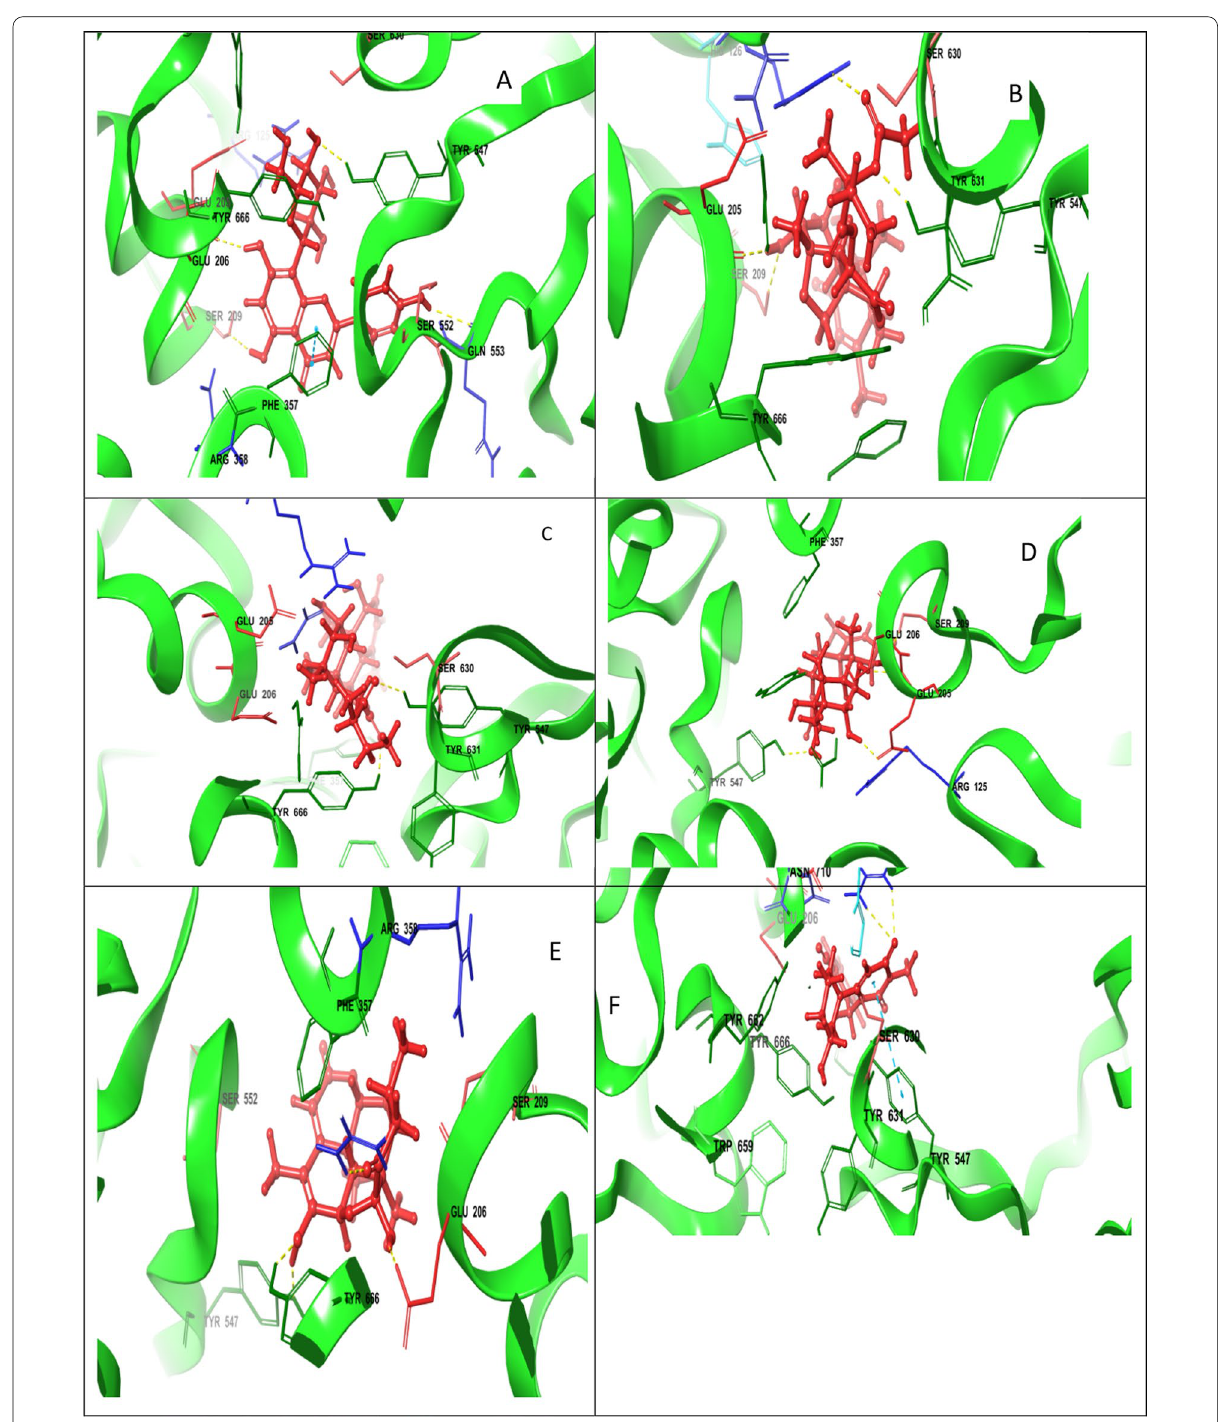
Fig. 4 3D-Molecular interactions of amino-acid residues of alpha-amylase with Quassia amara phytochemical constituents. A Vitexin, B Quassimarin, C Simalikalactone D, D Brucein D, E Quassinol and F